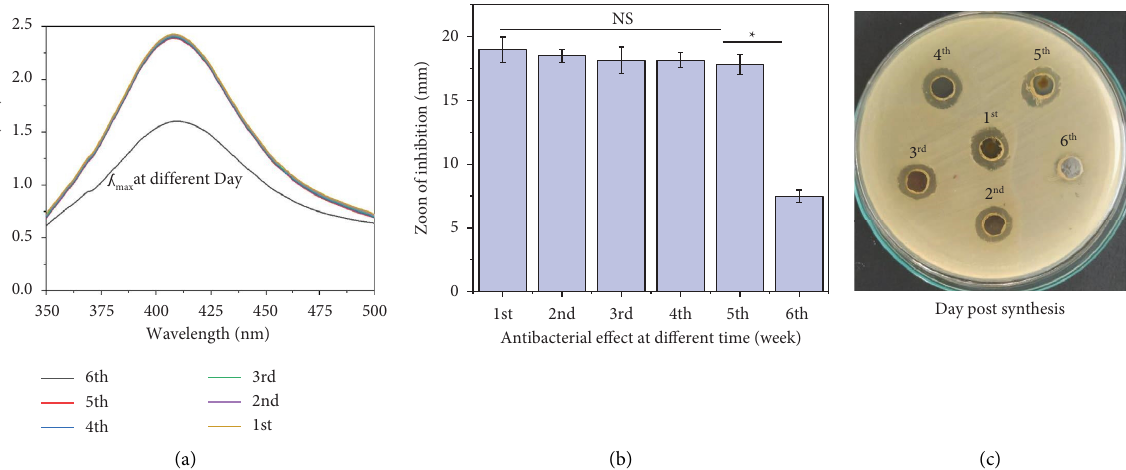
Figure 10: Stability test of synthesized Ag-NPs: (a) absorbance peak ( λ zone of inhibition surrounding Ag-NPs treated well.